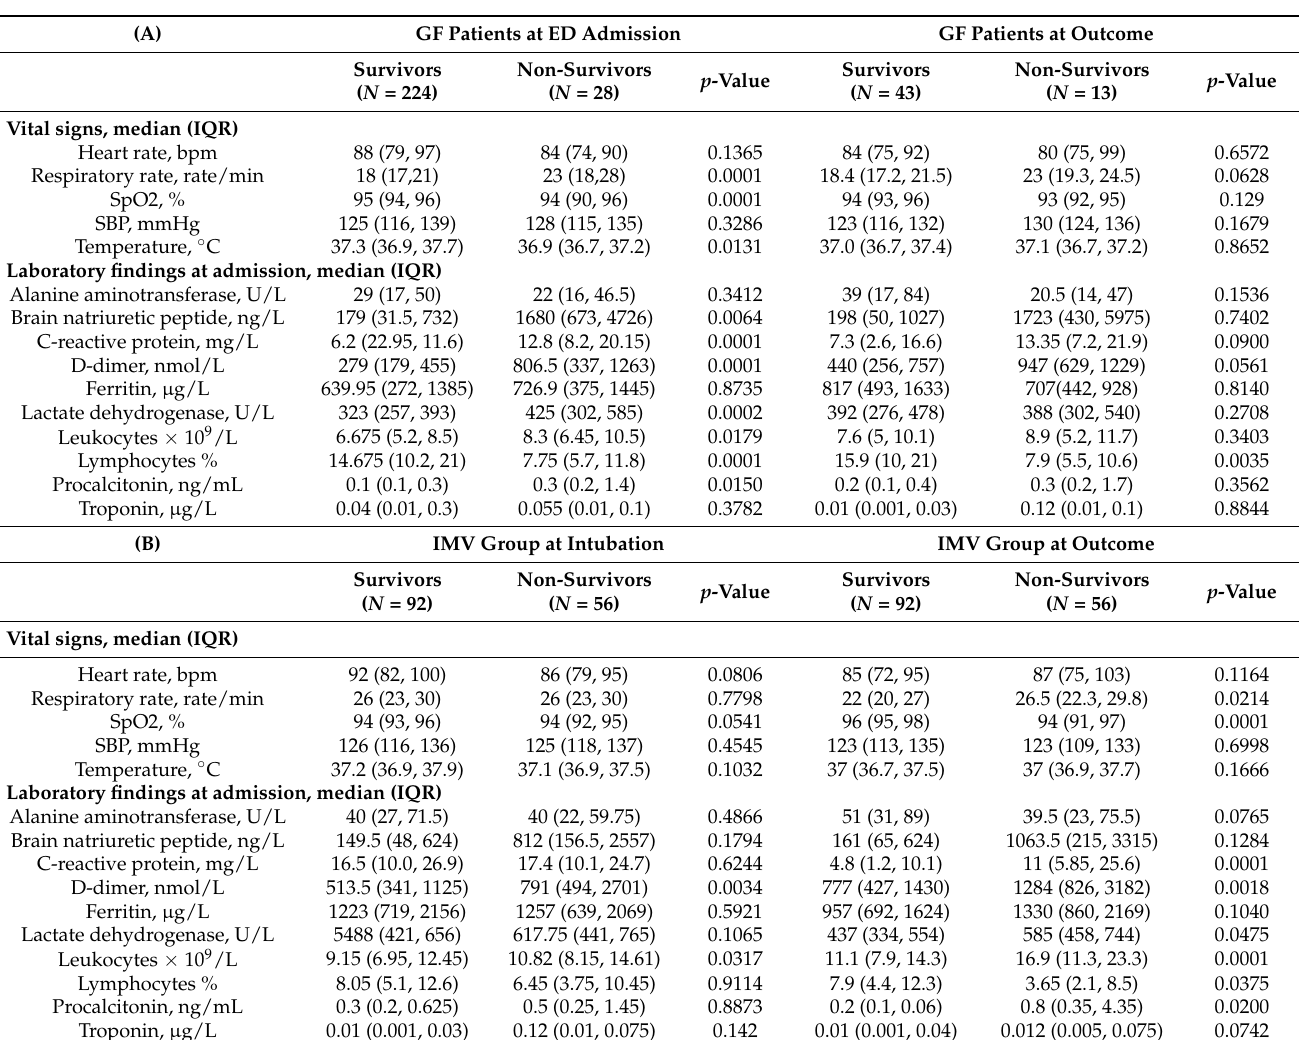
Table 2. Vital signs and laboratory tests. (A) General floor (GF) group at ED admission and at outcome, and (B) invasive mechanical ventilation (IMV) group at intubation and at outcome, separated by survivors and non-survivors. Group comparison of continuous variables in medians and interquartile ranges (IQR) used the Mann–Whitney U test. The p -value column indicates significance between survivors and non-survivors. Values inside parentheses indicate